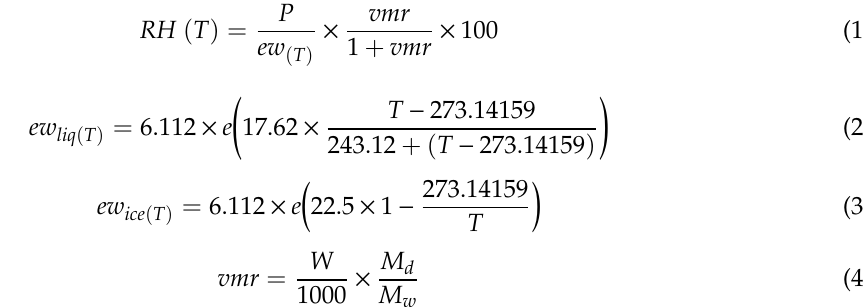
T g : table temperature in K ew liq ( Tg ) : saturation partial pressure over liquid water at a given temperature ew ice ( Tg ) : saturation partial pressure over ice at a given temperature M w = 18.0160 (molecular weight of